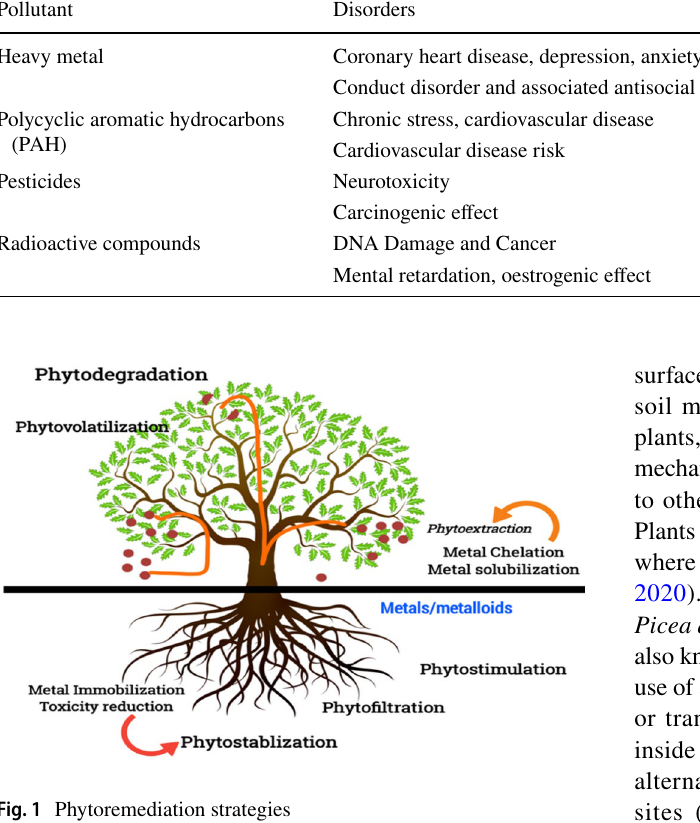
Fig. 1 Phytoremediation